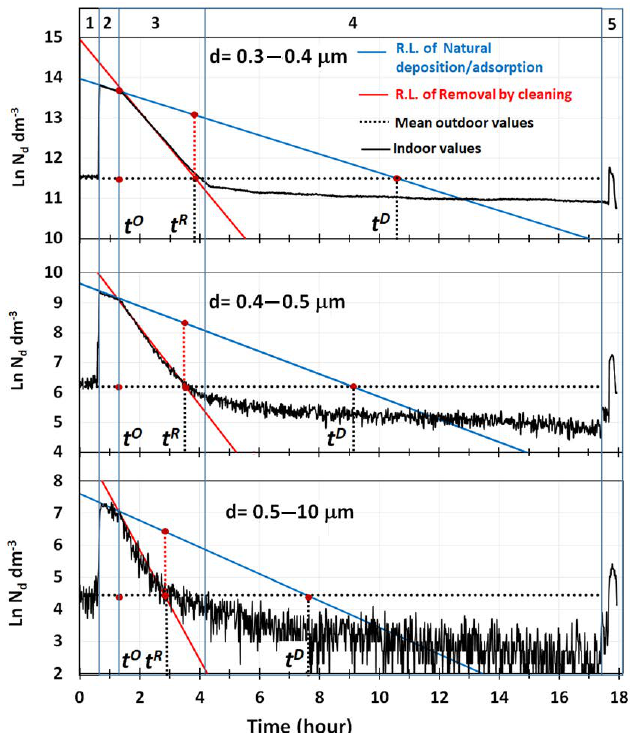
Figure 2. Semi-logarithmic plots of the particle number concentrations vs. time recorded in the testing room for three of the size ranges investigated. Data refer to the experiments performed with diesel exhaust emission using the GIOEL air cleaner run at the minimum speed. Numbers at the top of the graphs refer to the various phases of the experiment: (1) room under ambient atmospheric conditions; (2) introduction and mixing of pollutants into the room (mixing phase); (3) activation of the cleaning device (removal phase); (4) end of the removal phase; and (5) room opening and end of the experiment. Blue solid line = regression line for natural deposition/adsorption, red solid line = regression line for the removal by cleaning, and horizontal black dotted line = mean outdoor concentration. RL = regression line; t 0 = starting time of cleaning; t D = time when 100% particles are removed by deposition/adsorption; and t R = time when 100% of particles are removed by air